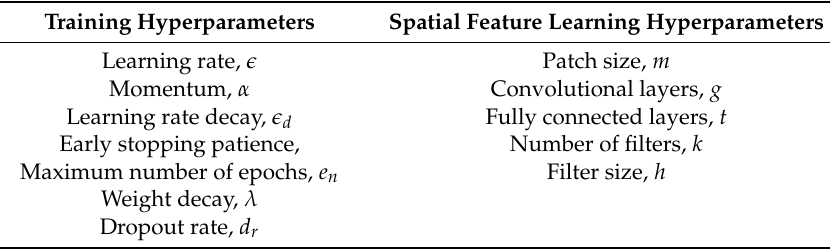
Table 1. Overview of CNN hyperparameters.